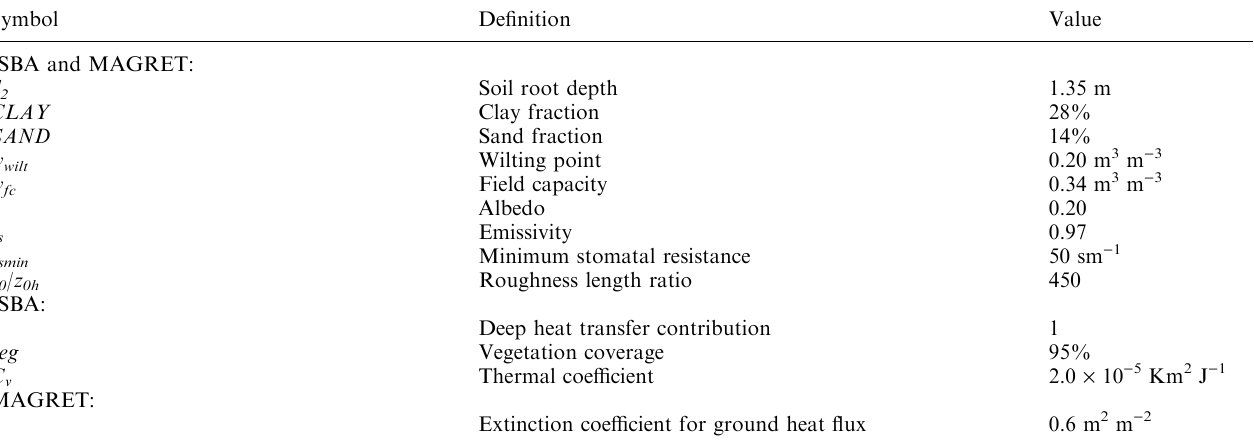
Table 1. The soil and vegetation structure parameters over the MUREX fallow for ISBA and MAGRET Symbol Definition Value ISBA and MAGRET: